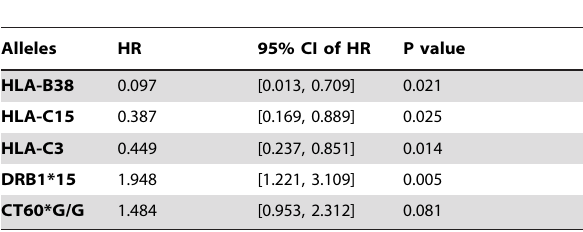
Table 4. Multivariate overall survival (OS)